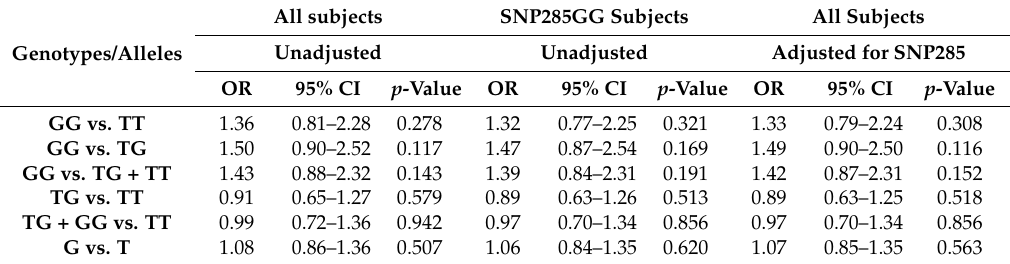
Table 1. Association of MDM2 SNP309 genotypes and alleles with breast cancer